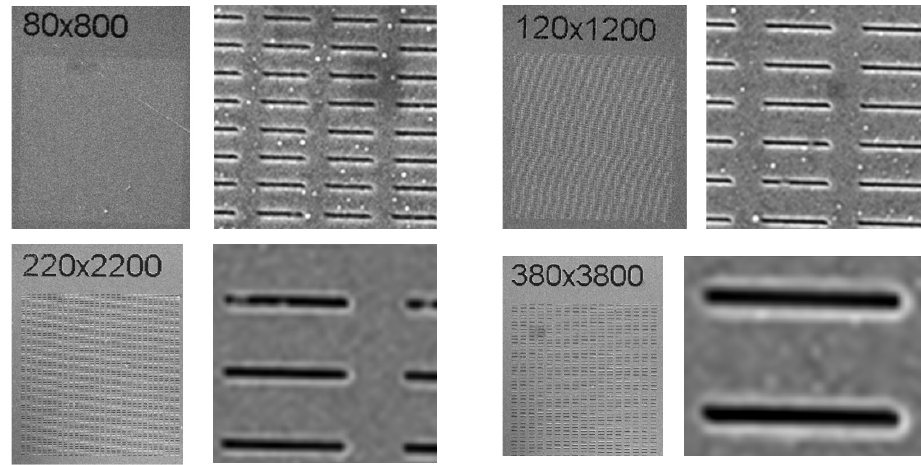
Figure 4. Scanning electron microscope images of dipole array structures.